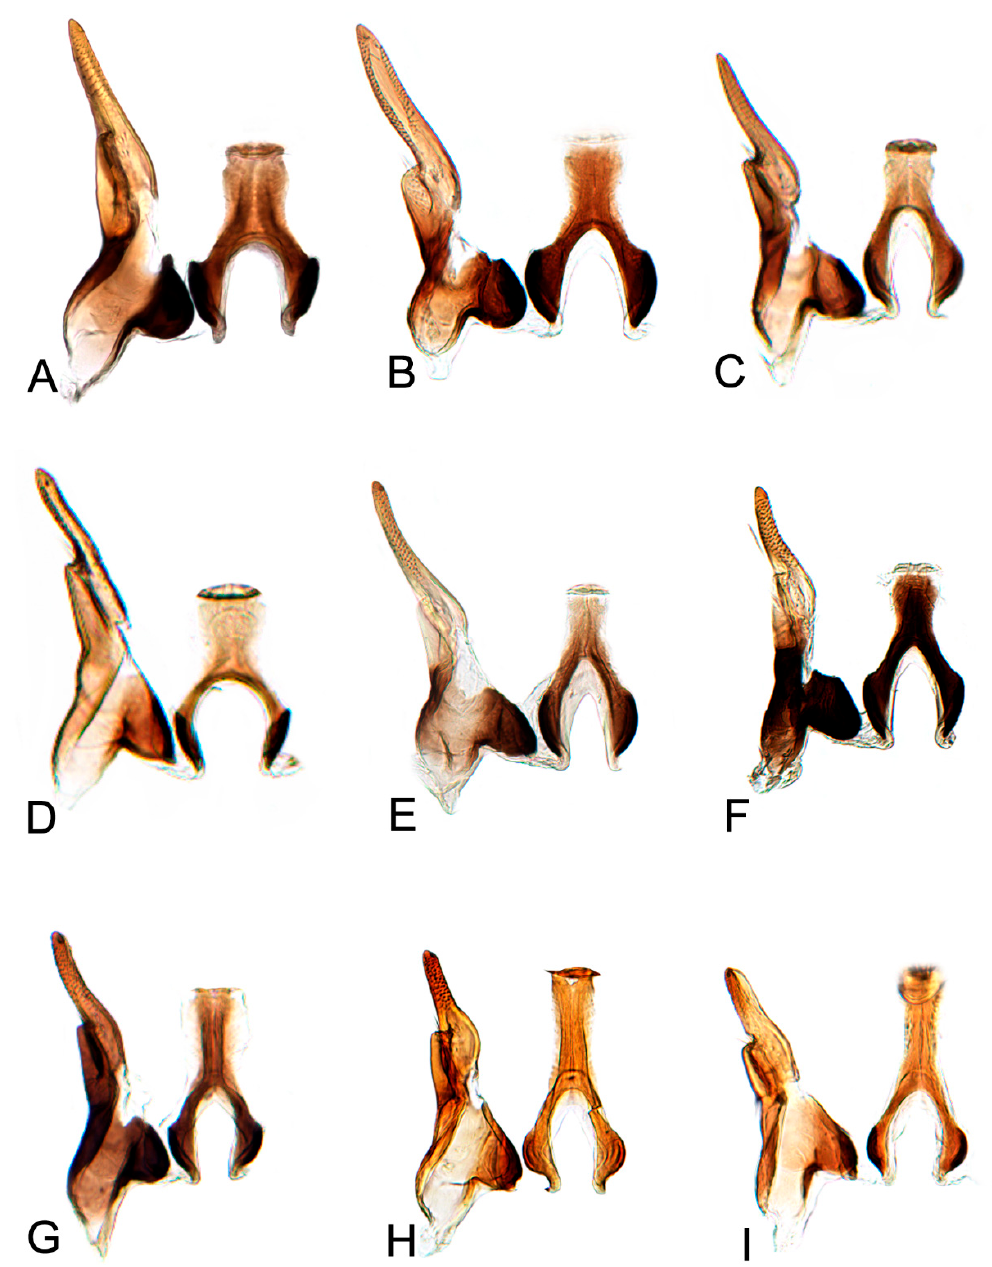
Figure 15. Style and connective, ventral view. ( A ) H. expansivus ; ( B ) H. ventralis ; ( C ) H. hamuleus ; ( D ) H. yuanmouensis ; ( E ) H. hamatus ; ( F ) H. fuscomaculatus ; ( G ) H. lii ; ( H ) H. phycitis ; and ( I ) H. paraphycitis .